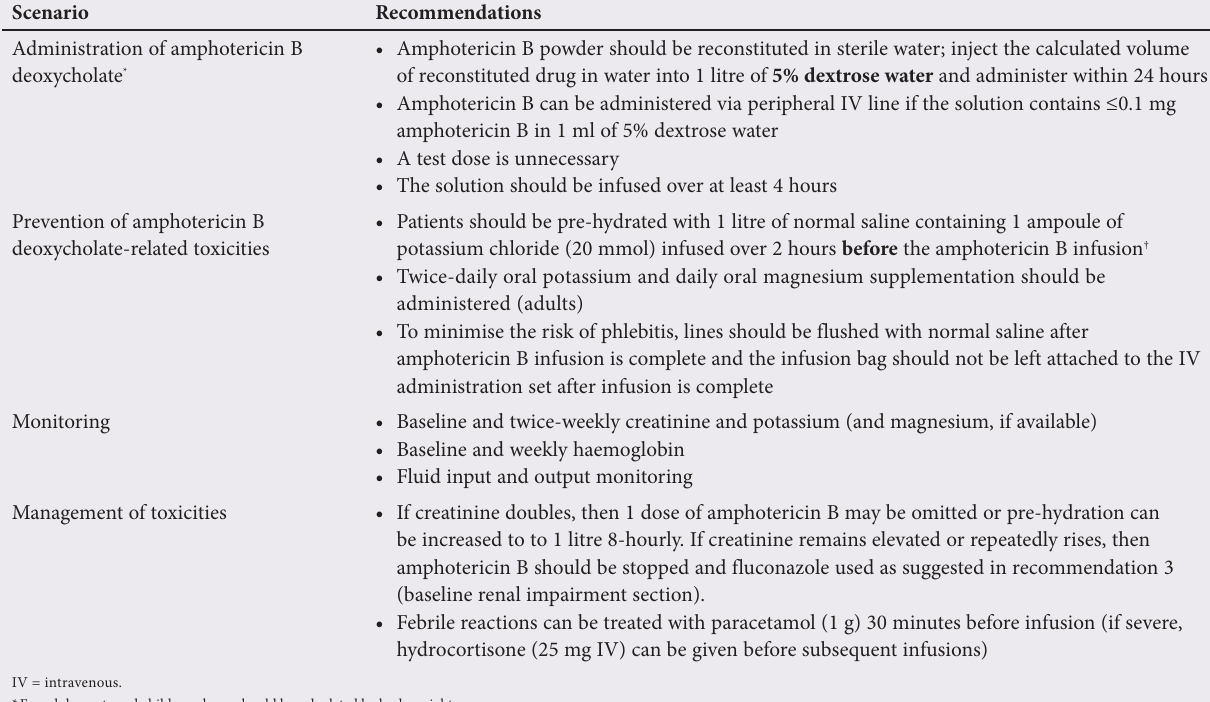
Table 4. Summary of recommendation 4: Amphotericin B toxicity prevention, monitoring and management